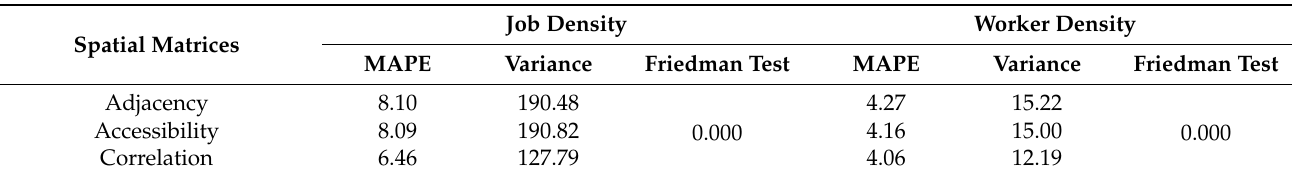
Table 4. Predictive performances of three different spatial